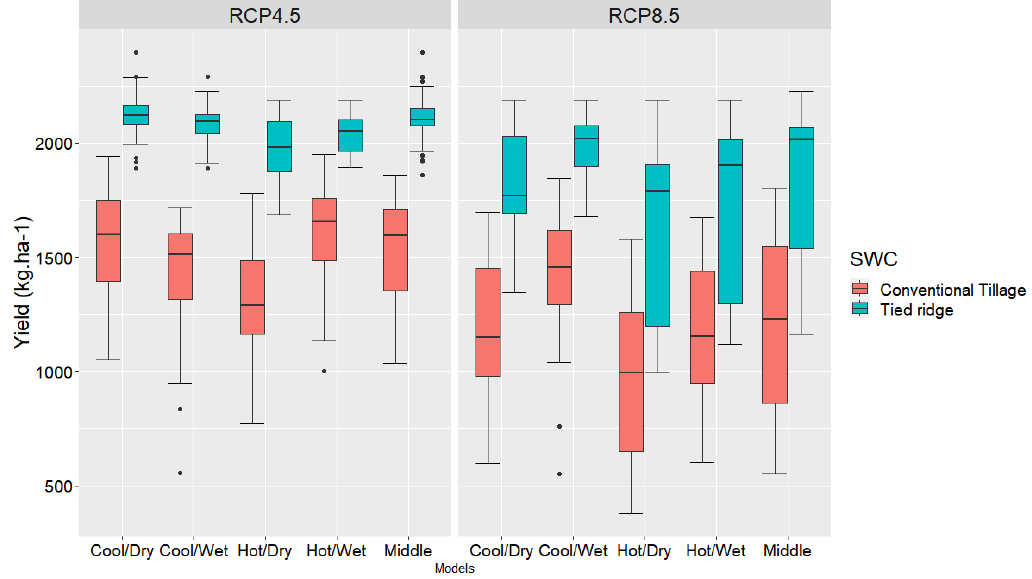
Figure 9. Effect of soil and water conservation practices on yield under RCP 4.5 and RCP 8.5